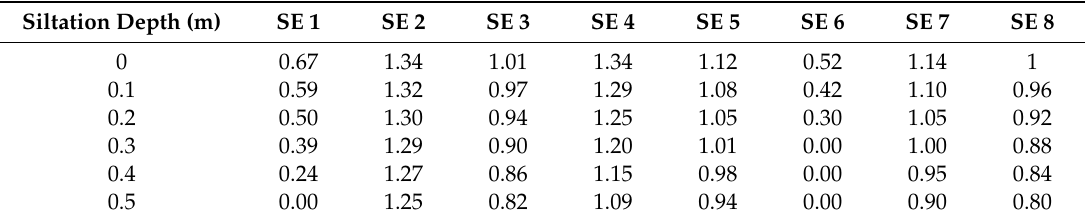
Table 5. E-flow requirements (m 3 / s) for di ff erent river segments (SE) under the medium hydrological connectivity scenario.